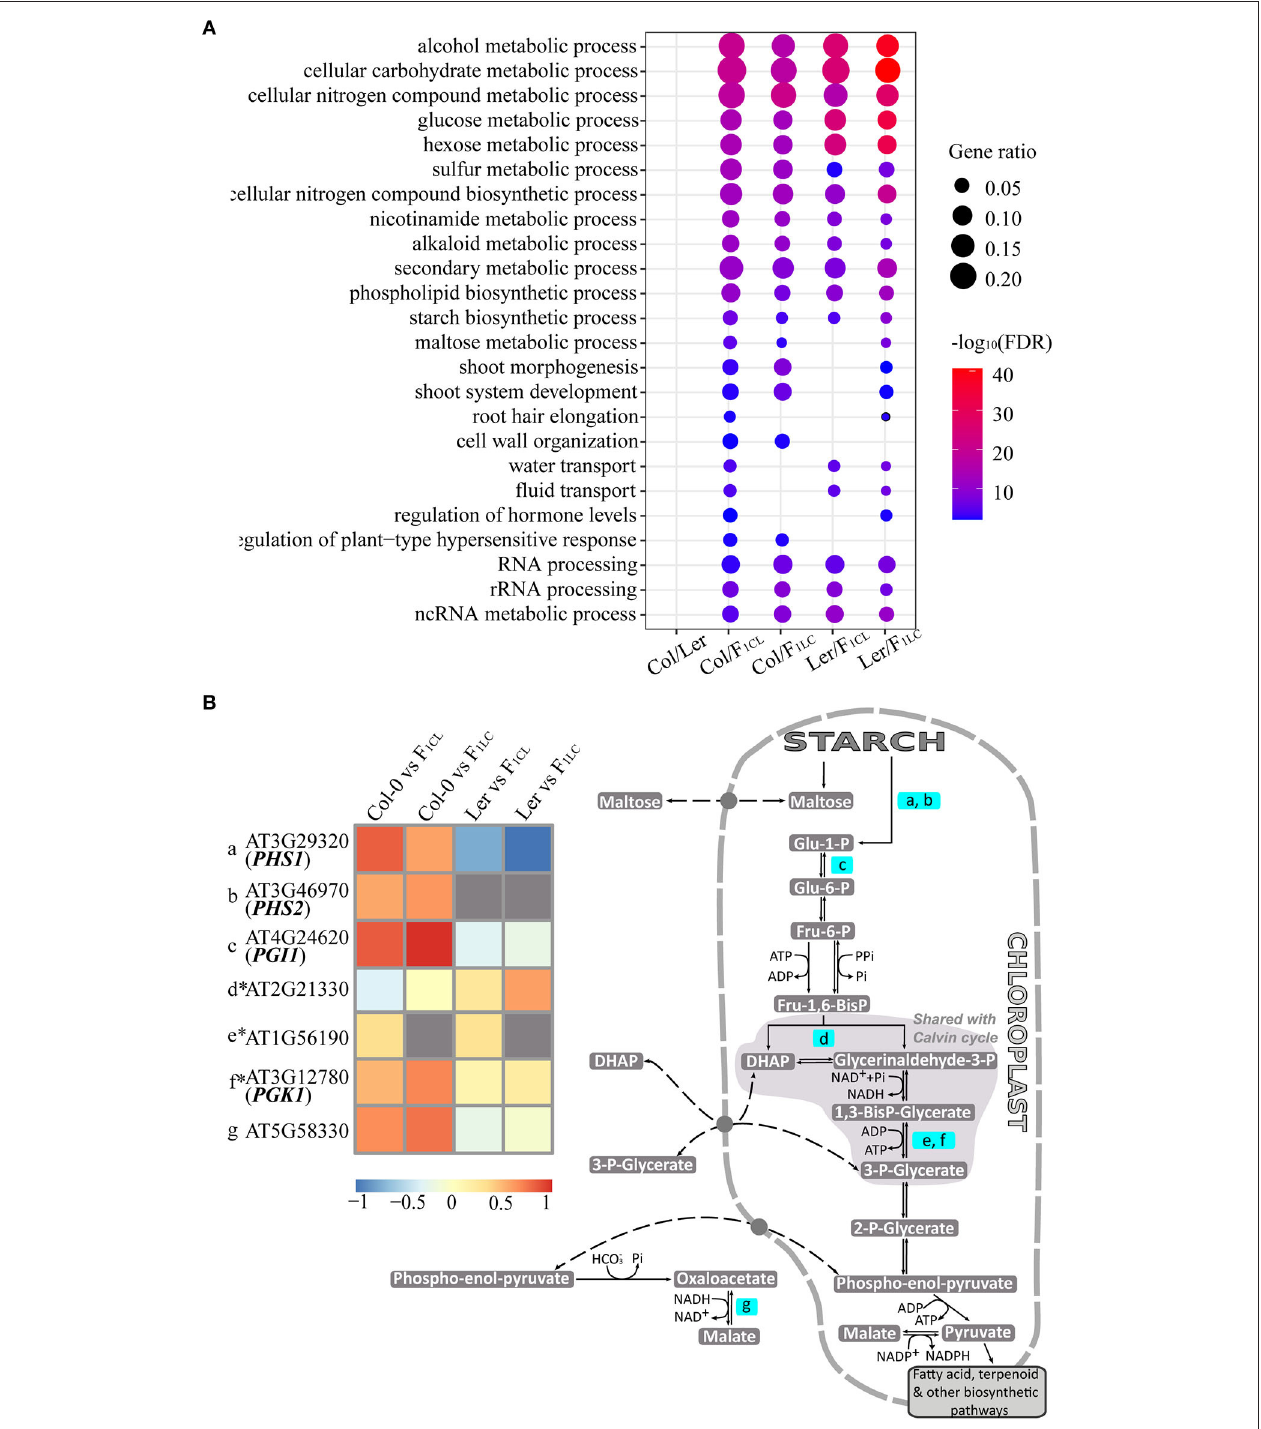
FIGURE 5 | Enriched biological functions of differentially m 6 A-methylated genes. (A) GO terms of genes associated with DMPs that are enriched only in comparisons of parents/hybrids, e.g., m 6 A-methylated peaks showing significant differences between Col-0 and F 1CL . Only some enriched GO terms are shown in the figure, and all GO terms are listed in Supplementary Table 4 . (B) A diagram for genes with DMPs involved in starch biosynthetic process related to biomass in Arabidopsis . The pathway is modified based on the Mapman database. Only genes in the pathway with DMPs are highlighted, of which m 6 A methylation differences between parents/hybrids are shown in the heatmap. *indicates the genes showing non-additive m 6 A methylation in the hybrids simultaneously.